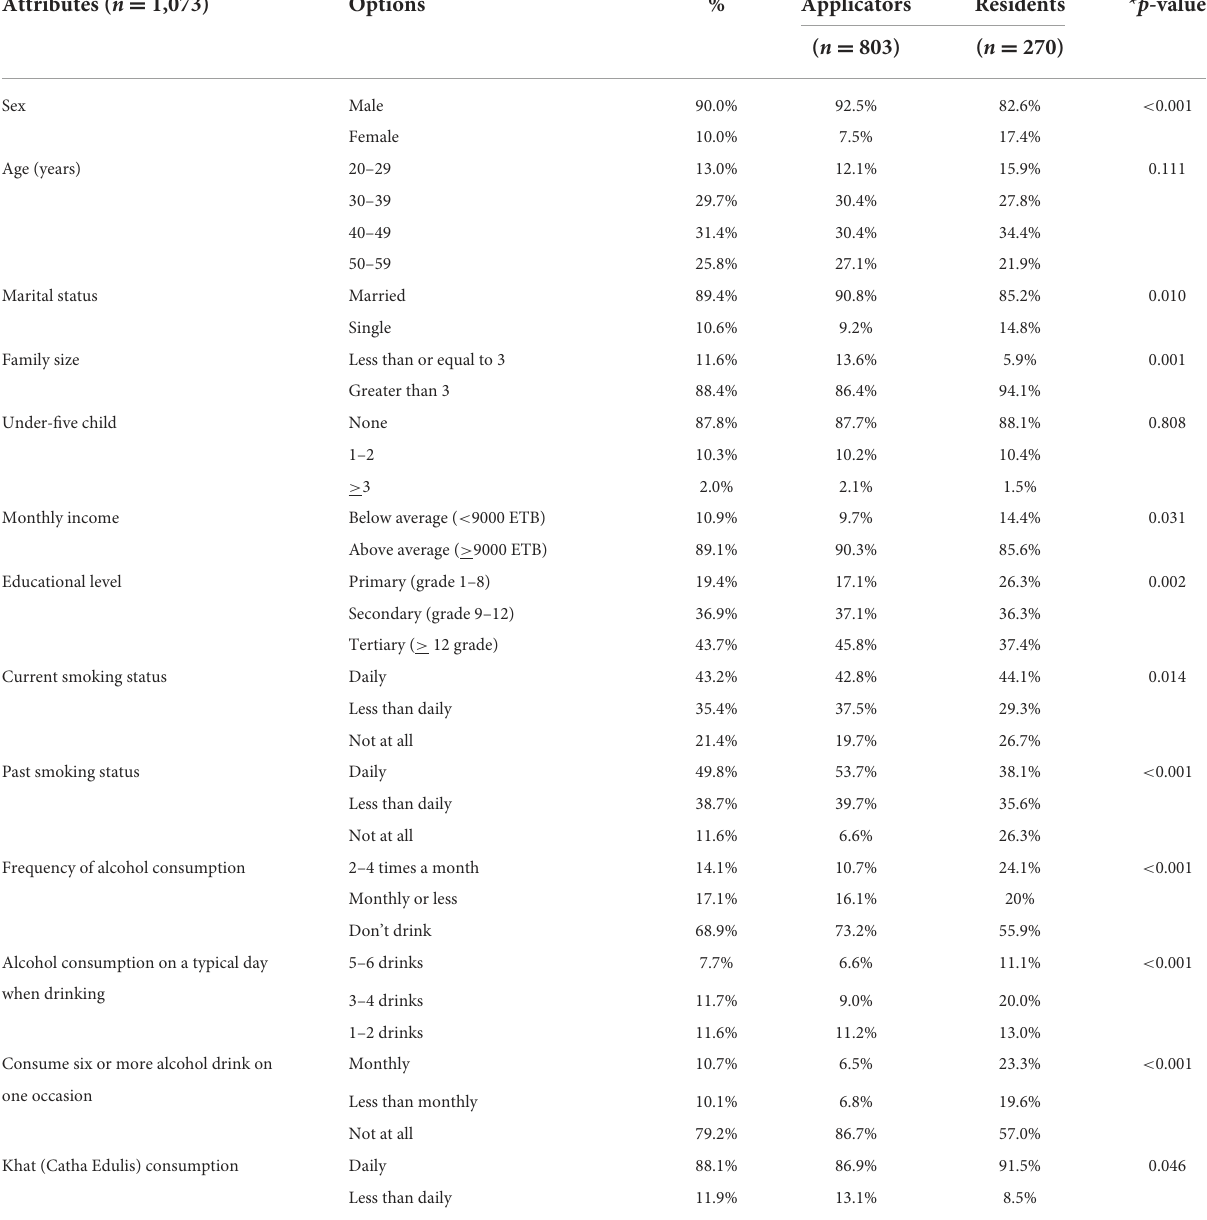
TABLE 1 Socio-demographic characteristics and lifestyle factors of pesticide applicators and residents in East Hararge Zone, Oromiya Region,